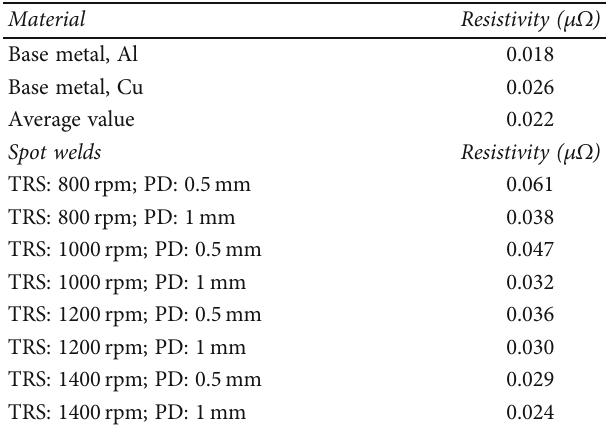
Figure 6: Hardness pro fi le of Al-Cu spot welds (rotational speed: 1200rpm and plunge depth: 0.5mm). Table 3: Electrical resistivities of the base metals and the spot welds of various process parameters (TRS: tool rotational speed; PD: plunge